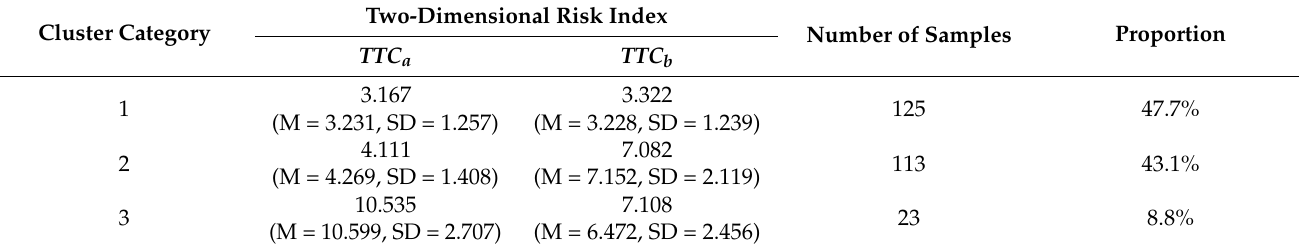
Figure 7. Results from the clustering analysis: red dot: category1; green star: category 2; blue cross: category 3. Table 3. Three types of risk cluster centers.